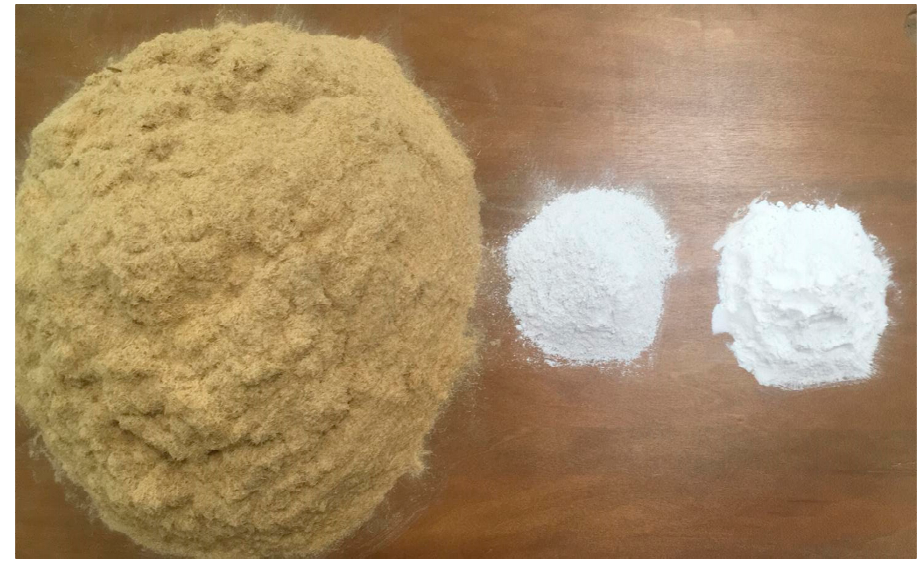
Figure 2. Giant reed (left), gypsum (center), and starch (right) particles used for manufacturing the experimental board type